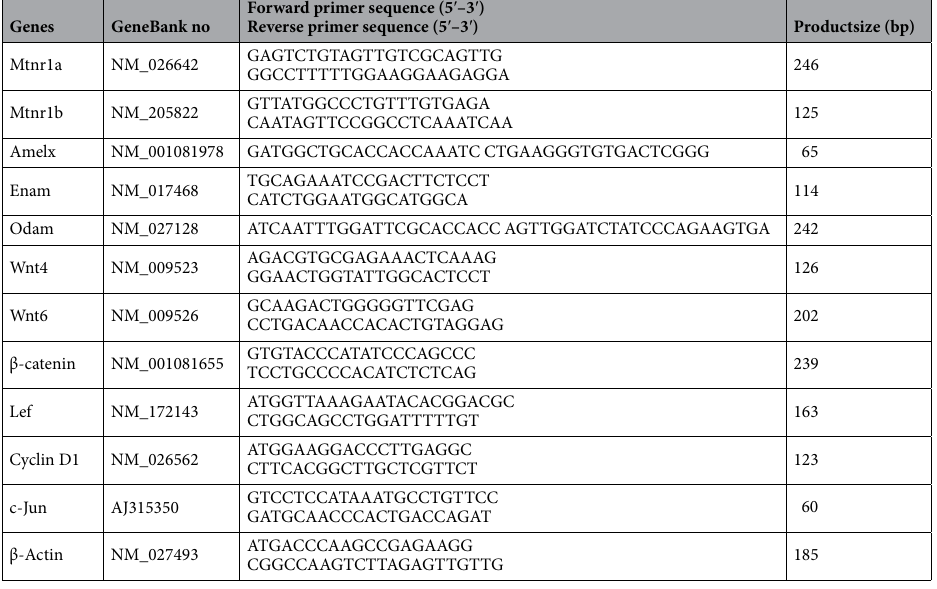
Table 1. Primer sequences used for